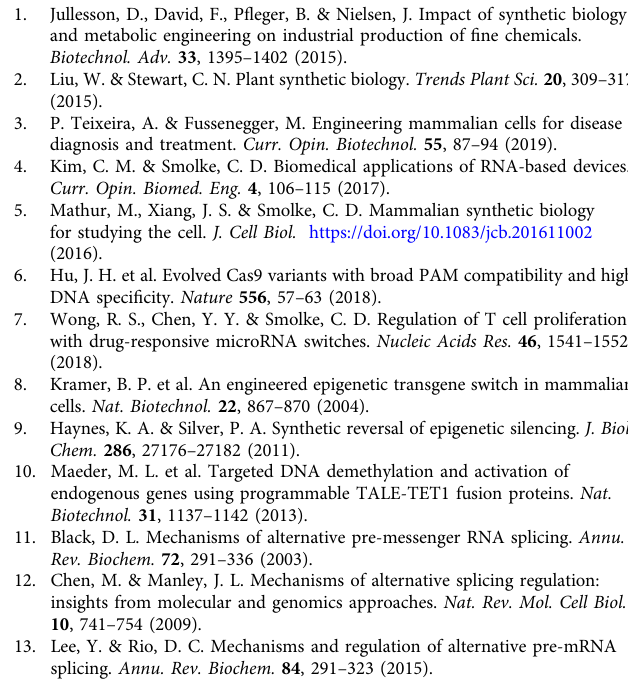
Supplementary Fig. 17. Median fl uorescence values were used to calculate fold activation as follows: mCherry = BFP from TALE þ BS Fold activation ¼ mCherry = BFP from BS “ mCherry/BFP ” represents the median mCherry or BFP fl uorescence intensity based on which color was being activated. Fold activations from biological triplicates were averaged and reported with an error range of ±1 standard